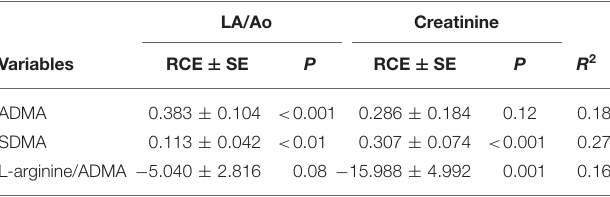
TABLE 5 | Final multivariable analysis for asymmetric dimethylarginine (ADMA), symmetric dimethylarginine (SDMA) and L-arginine/ADMA as response variables and LA/Ao and creatinine as explanatory